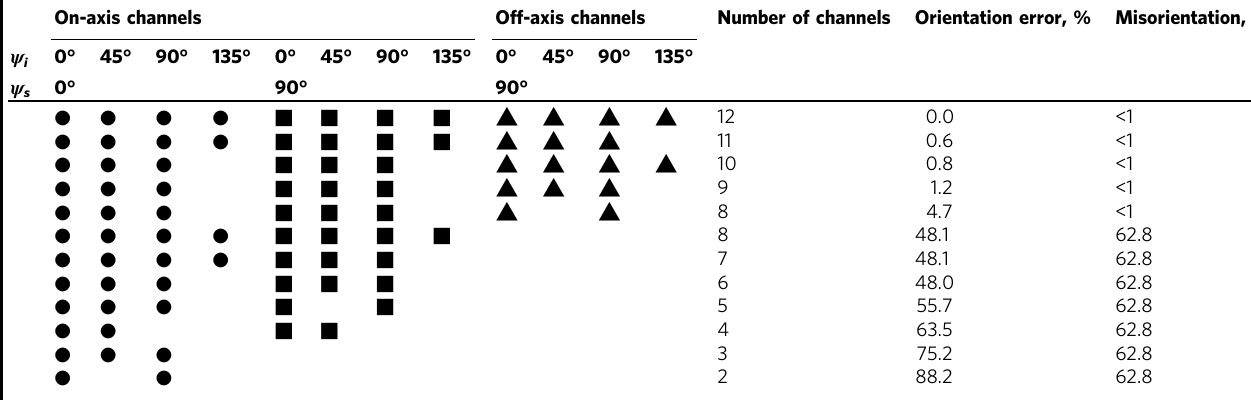
Table 1. The column “ Orientation error ” shows the percentage of